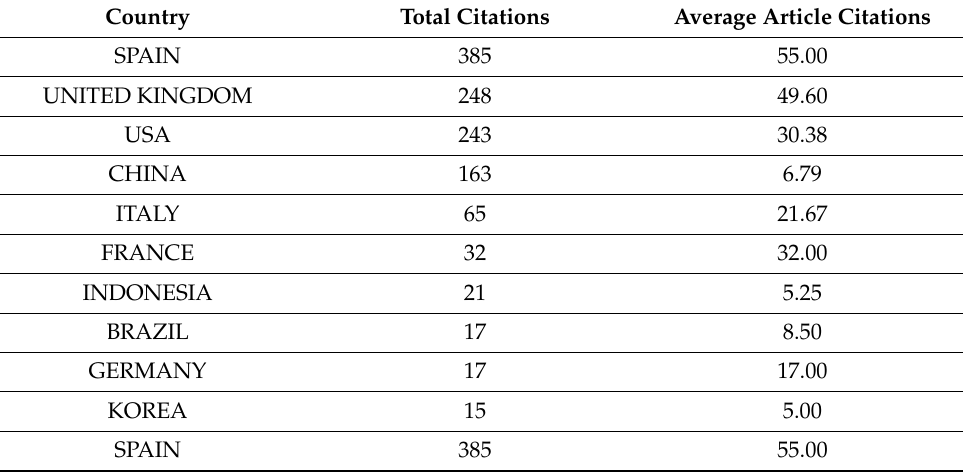
Table 3. Top countries in terms of publications and citations.